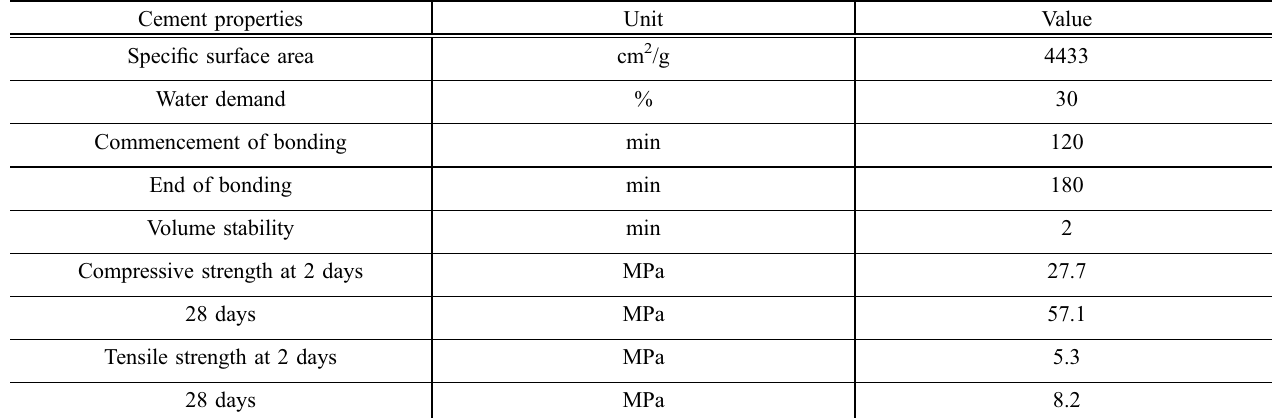
Table 1 Cement properties.